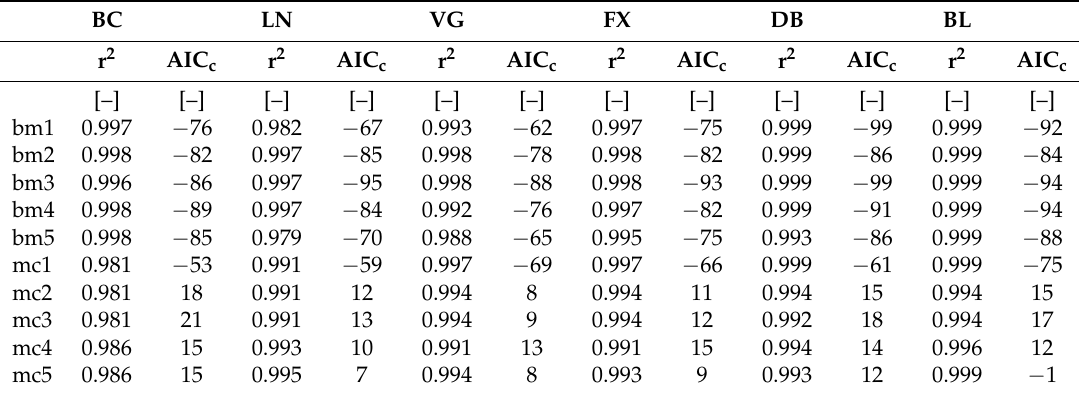
Table 6. Coefficients of determination (r 2 ) and AIC criterions (AIC c ) of the boulder marl (bm) and the